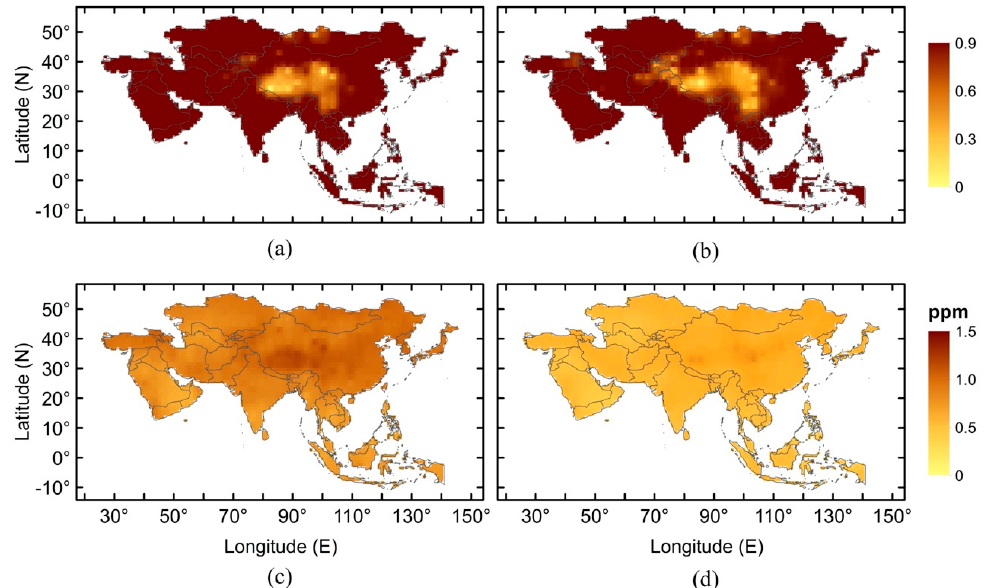
Figure 5. Spatial distributions of correlations between ( a ) the CarbonTracker and GOSAT; ( b ) the CarbonTracker and OCO-2; and mean posteriori estimate of XCO 2 uncertainty in ( c ) GOSAT; and ( d )